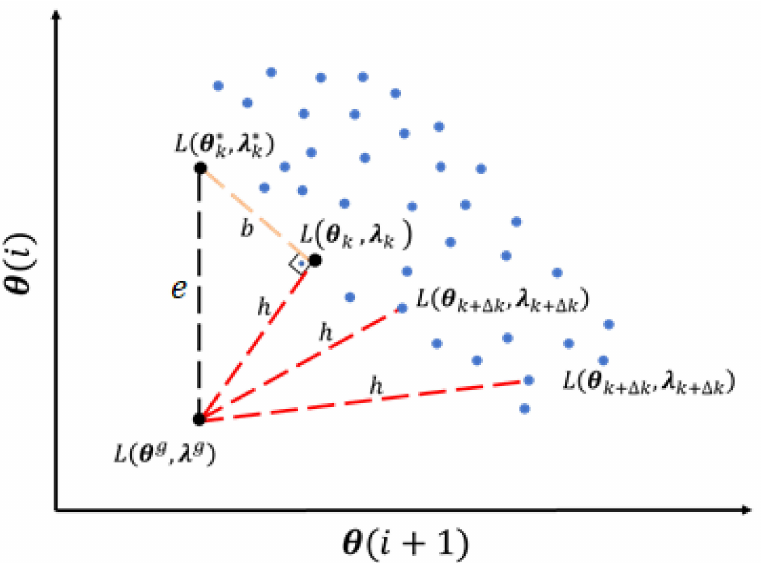
Figure 1. The resulting space formed by the overall population originated by the algorithm. The relationship between the value of each particle with a theoretical global minimum is expressed in terms of Pythagorean theorem. Based on this theorem it is presented a schematical representation of the concepts used in the deductions of the Fisher–Snedecor